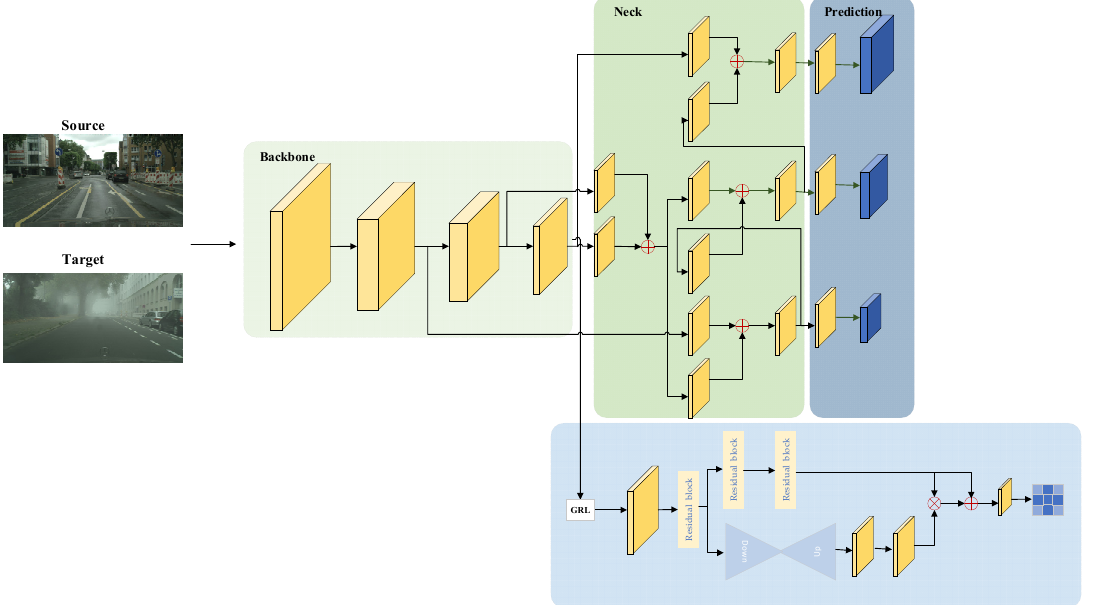
Figure 2. The overall structure of our framework. In this method, the spatial domain alignment module is added after the backbone network to predict the domain confidence of different locations and align the target and background effectively.